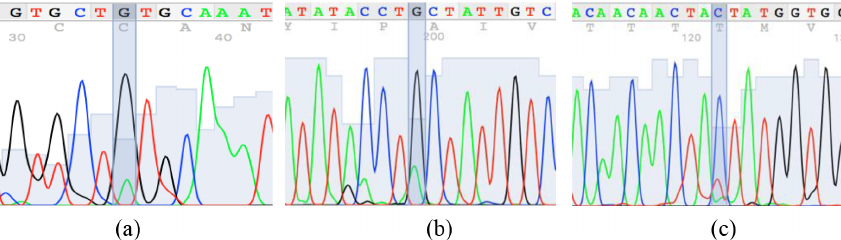
Figure 2. Sequence chromatogram of the amplified region of the ovine KAP22-1 in Egyptian sheep showing the identified single-nucleotide polymorphisms (A, B and